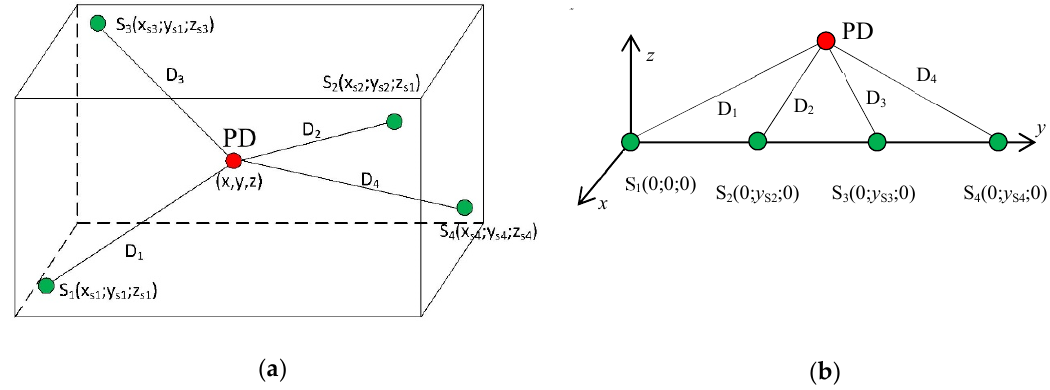
Figure 11. The general ( a ) and linear ( b ) geometrical configurations of the signal source (PD) and sensors S 1 , S 2 , S 3 , S 4 .